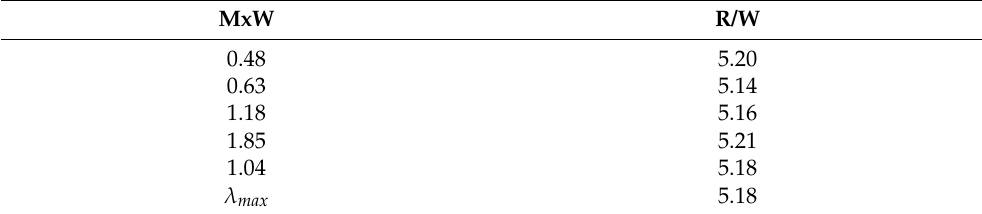
Table 9. Priority matrix.